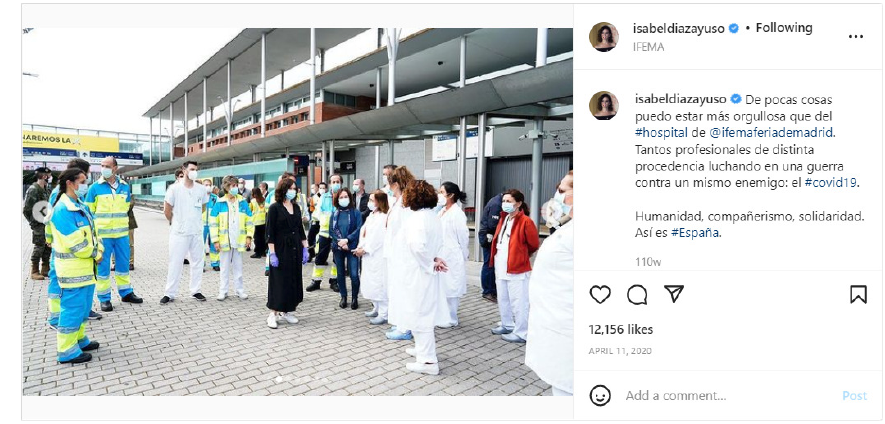
Figure 3. Díaz Ayuso surrounded by medical workers while visiting a provisional hospital on April 11,